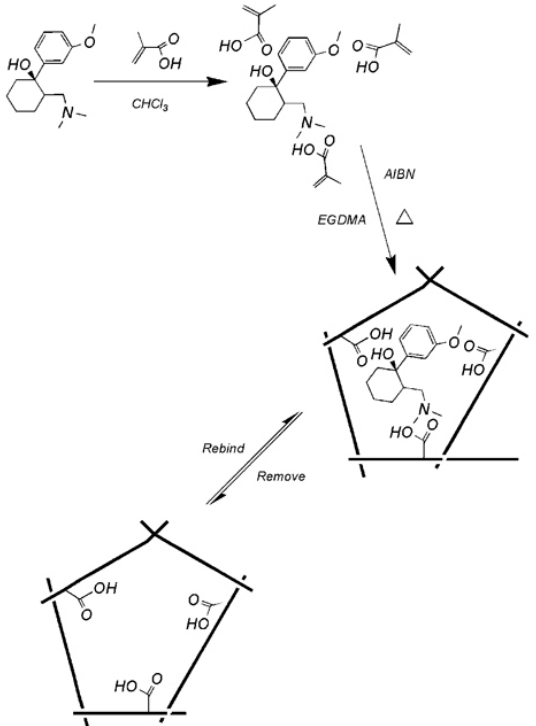
Figure 2. Schematic representation of the MIP synthesis for